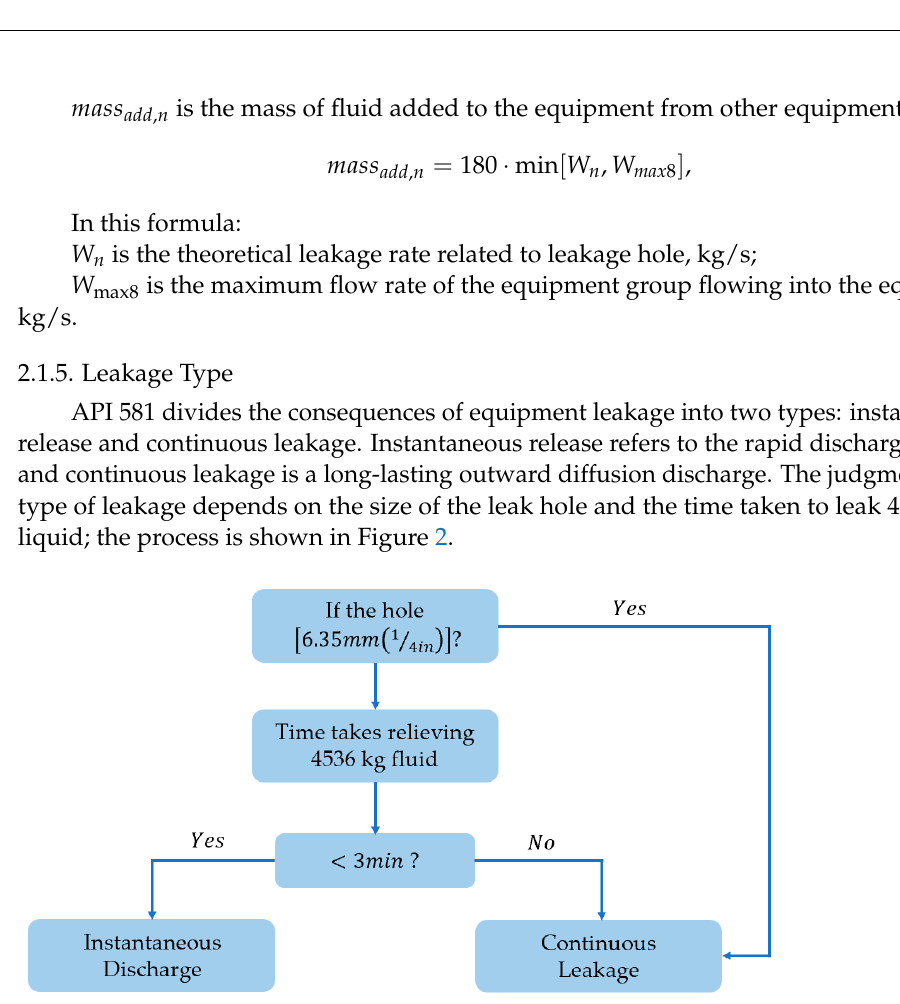
Figure 2. Determination process of equipment leakage type.